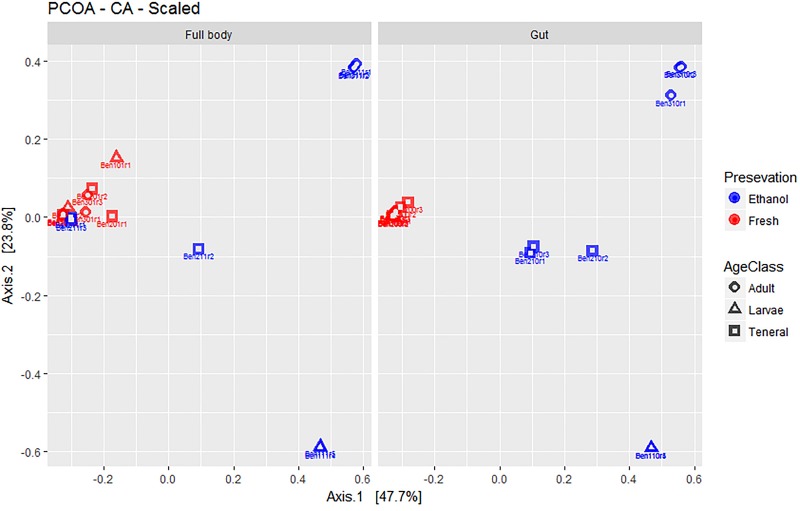
Multivariate ordination (PCOA) of gut microbial assemblages in fresh and ethanol preserved specimens of larvae, teneral, and adults of C. capitata. For clarity, the same PCOA is represented twice, either with full body (left) or gut-dissected samples (right) indicated. Colors refer to preservation (blue: ethanol preserved and red: fresh) and shapes to life stage (circle: adult, triangle: larvae, square: teneral).